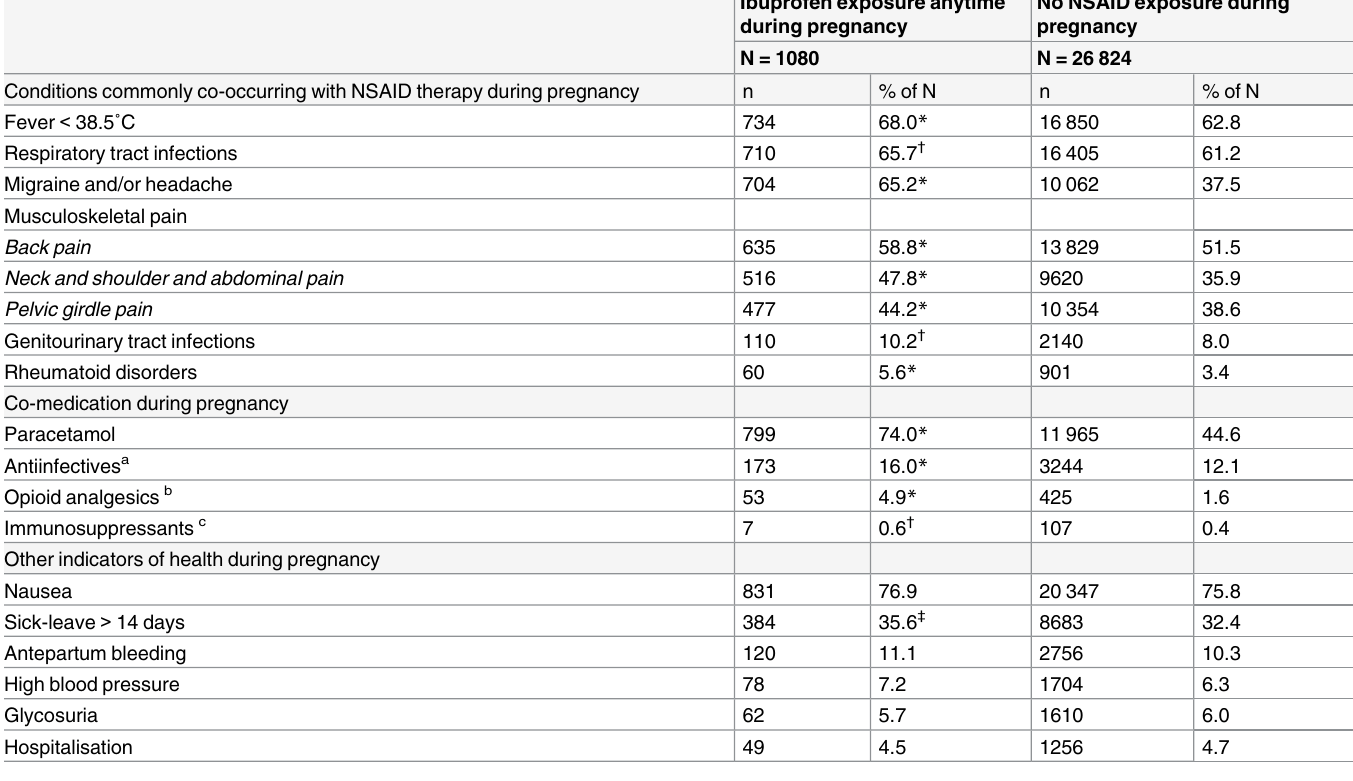
Table 2. Medical characteristics of the exposed and the unexposed